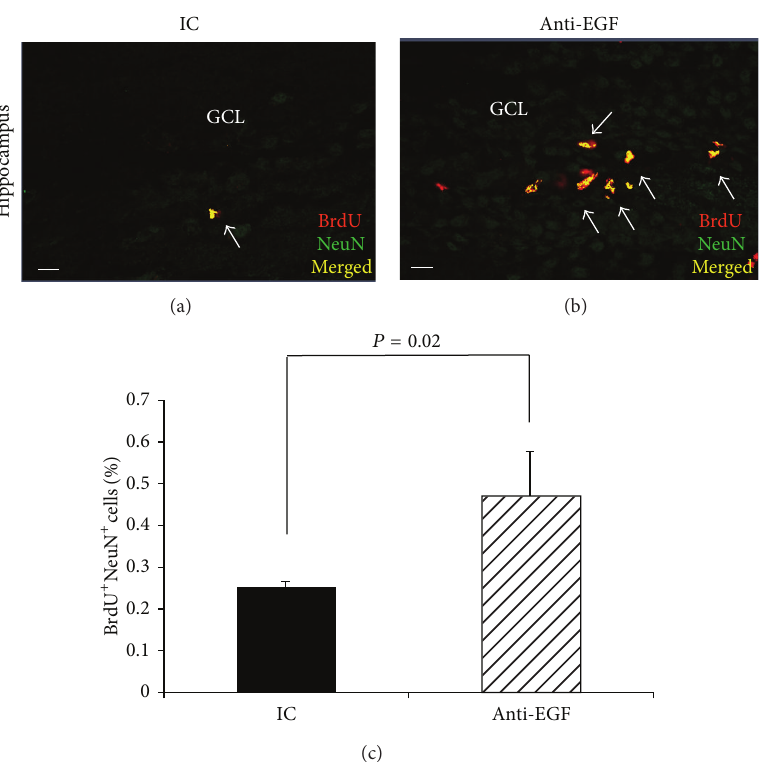
Figure 3: Elevated numbers of de novo mature neurons in the GCL of anti-EGF Ab-treated EAE mice. Immunohistochemical labeling of BrdU + NeuN + cells in the GCL of IC-treated mice (a) and of anti-EGF Ab-treated mice (b) on day 18 after immunization. Quantification of %BrdU + NeuN + cells (c) revealed increased numbers of BrdU + NeuN + in the GCL of anti-EGF Ab-treated EAE mice compared to IC-treated mice. Images were obtained using a confocal microscopy, coronal sections. Quantification was performed using ZEN 2011 software on 3 sections from each mouse (3 mice from each group, total 𝑛 = 9 ). GCL , granular cell layer. Scale bar: 10 𝜇 m (magnification = × 63).